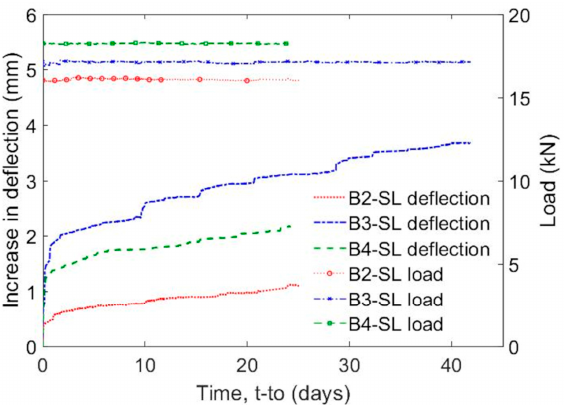
Figure 13. Sustained load and deflection with time for the first stage (series I).